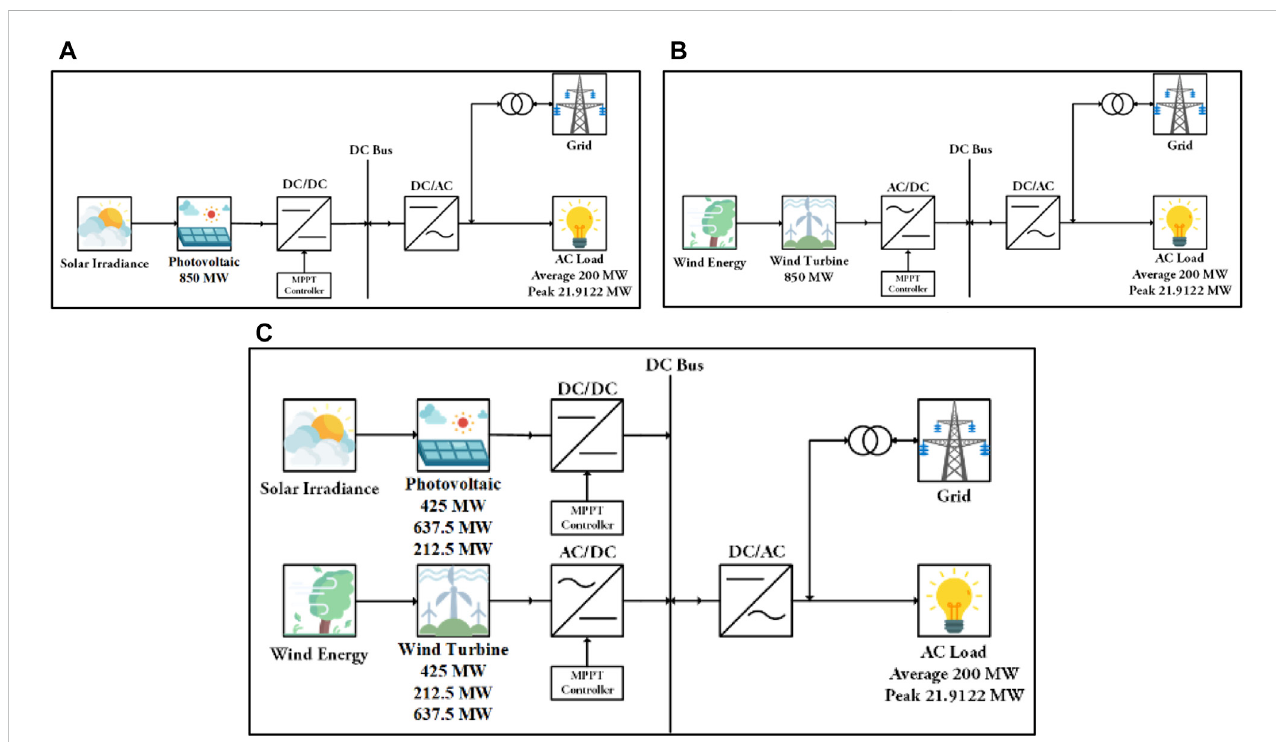
FIGURE 6 Hybrid microgrid without an ESS. (A) PV on-grid connected; (B) wind turbine on-grid connected; (C) PV and wind turbine on-grid connected with PVs and wind turbines of three different